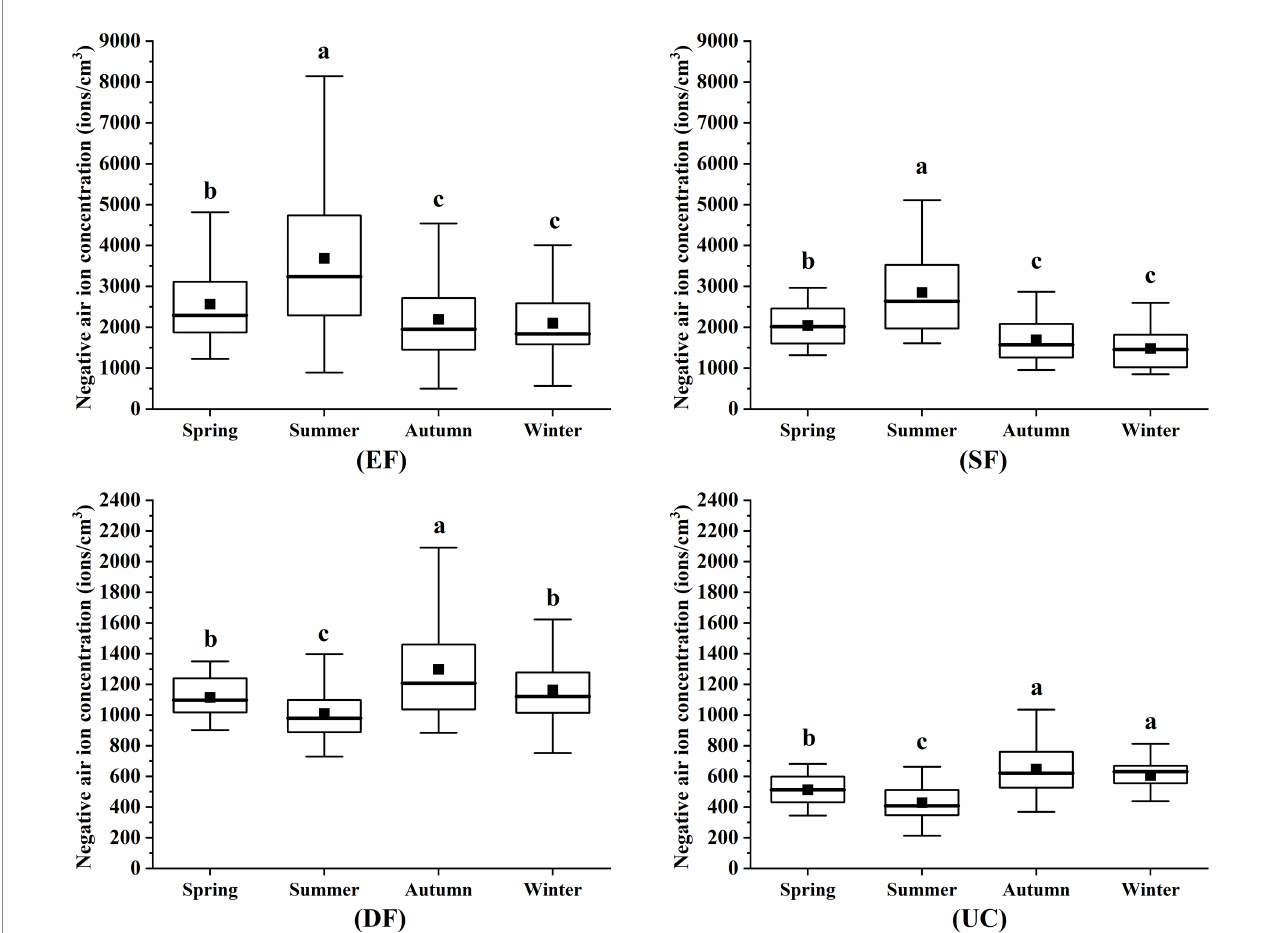
FIGURE 4 Seasonal variations of NAIC of urban forests in different geographical spaces. EF, Exurban forest; SF, Suburban forest; DF, Downtown forest; UC, Urban control. The different lowercase letters indicate significant difference of each geographical space in different seasons ( p < 0.05).